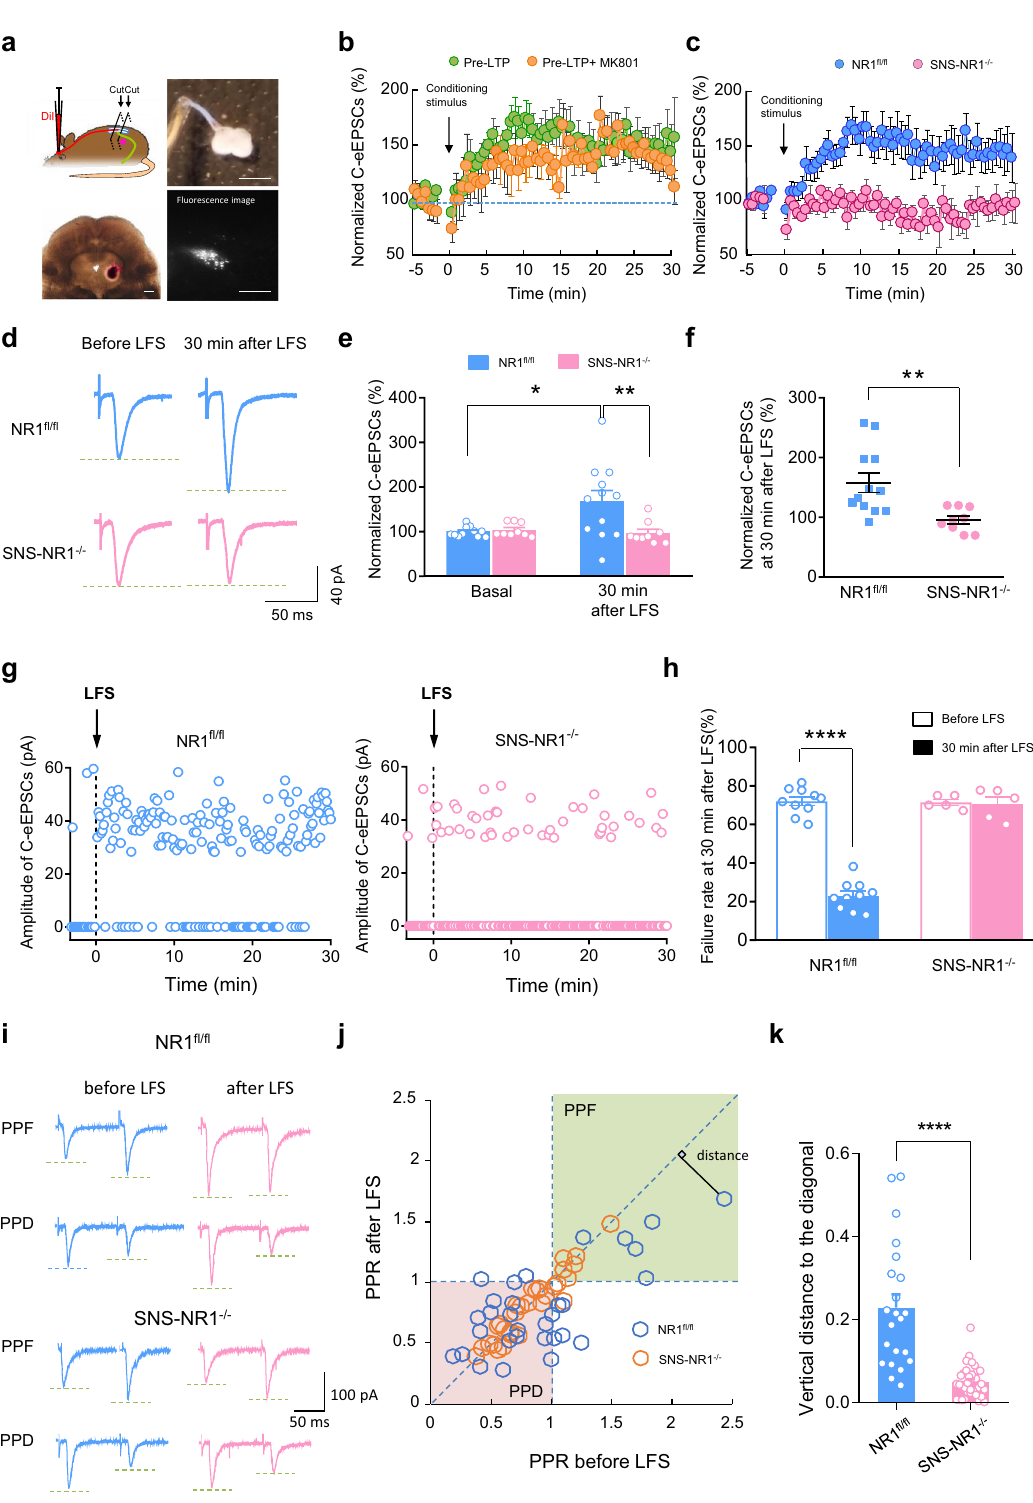
went on to test the effect of exogenous NMDA. Given a crucial role of PreNMDARs in spinal pre-LTP, we expect that activation of PreNMDARs by exogenous NMDA would potentiate synaptic transmission between C nociceptors and spinal-PAG projection neurons. However, acute bath application of NMDA (50 μ M, 30 s) depressed but not potentiated C-eEPSCs in spinal slices from naive NR1 fl / fl mice (Fig. 2a, b, 65.5 ± 7.1% of a